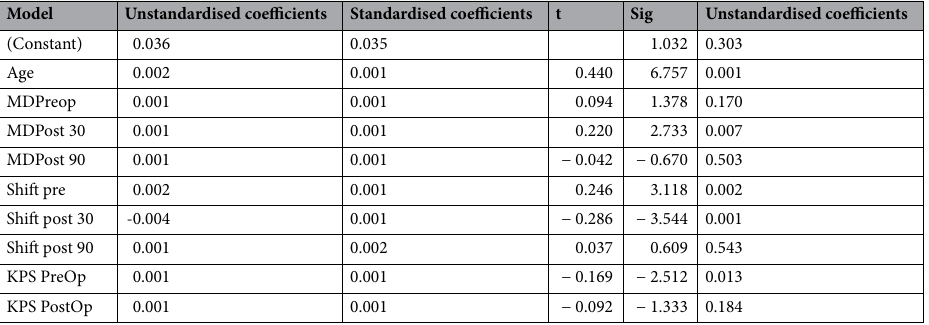
Table 3. Correlation of the RCA index with the following parameters: age, MDPost 30, Shift pre, Shift post 30, and KPS PreOp.